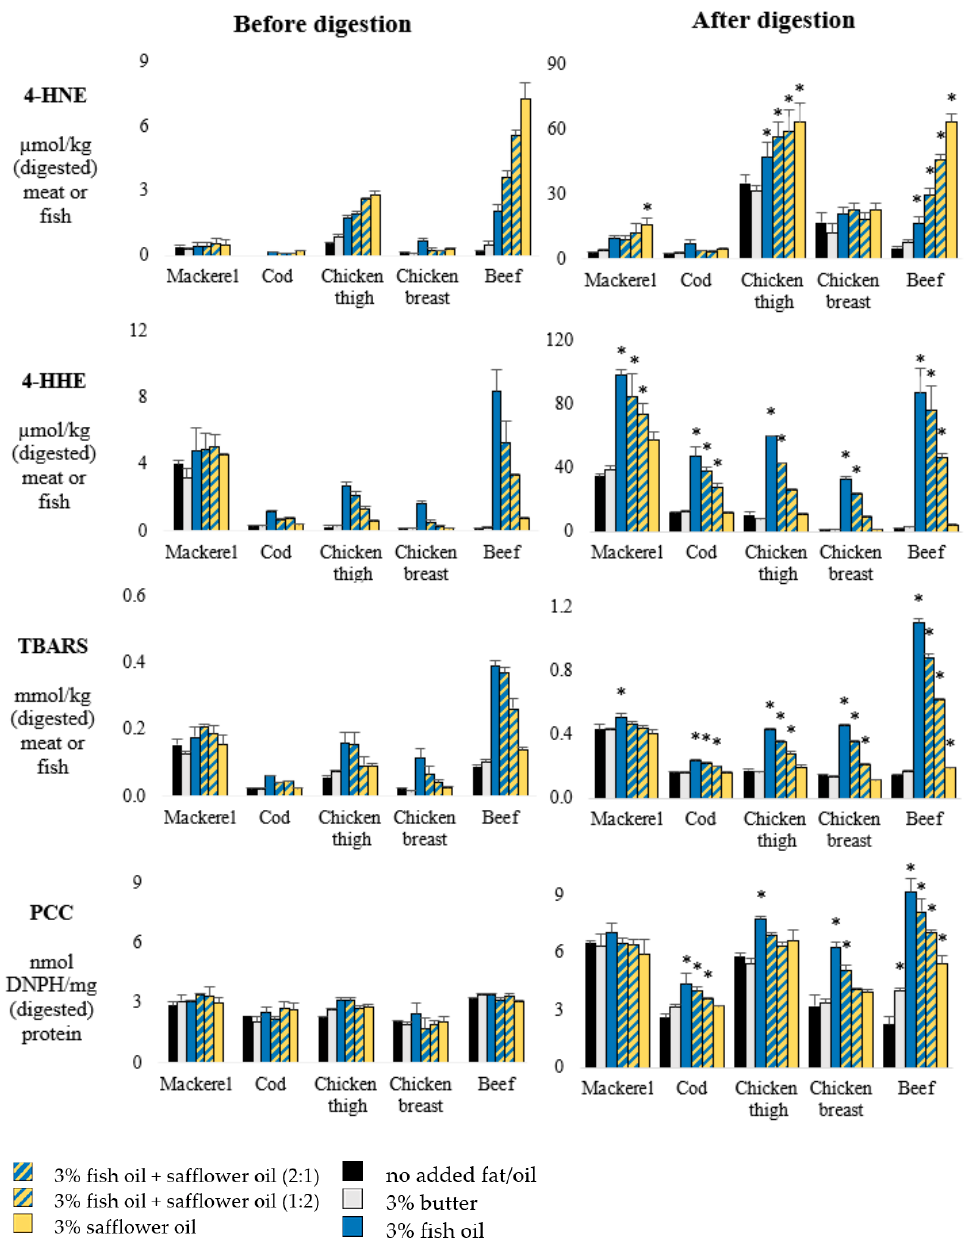
Figure 2. Lipid and protein oxidation in heated muscle-based foods before the addition of digestive juices ( Left ) and after in vitro gastrointestinal digestion ( Right ) (Experiment 1). 4-HNE = 4-hydroxy-2-nonenal, 4-HHE = 4-hydroxy-2-hexenal, TBARS = thiobarbituric acid reactive substances, PCC = protein carbonyl compounds. Error bars indicate standard deviation. Asterisk (*) indicates that the treatment with added fat substrate is significantly different ( p < 0.05) compared to the muscle food without added fat.